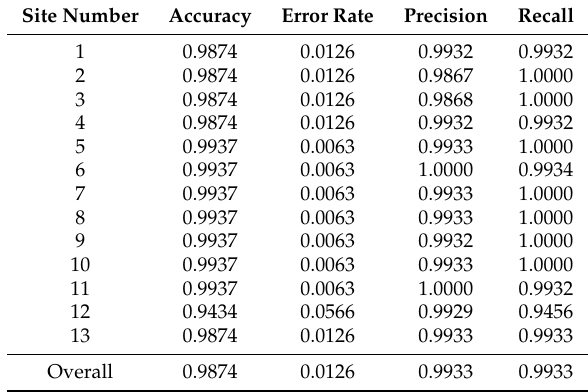
Table 8. Fault detection of individual